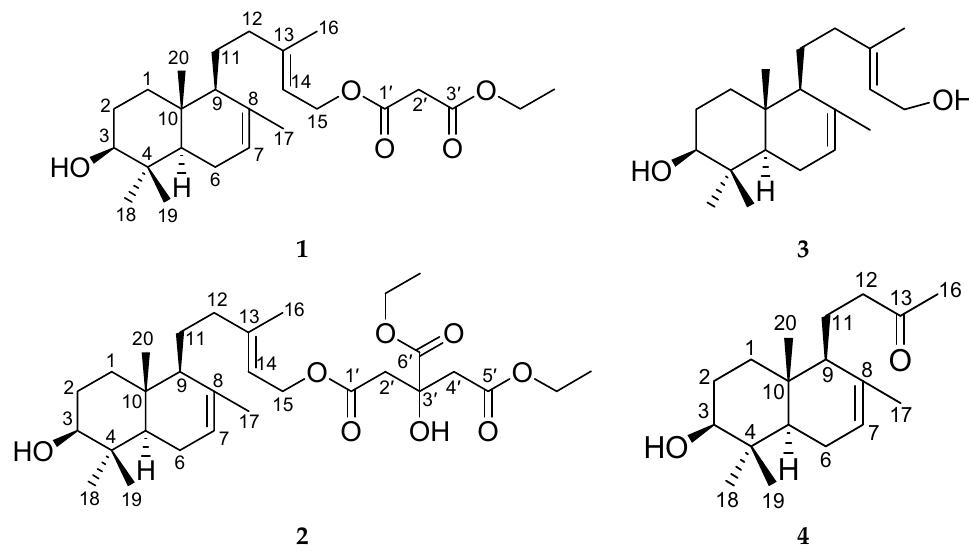
Figure 1. The chemical structures of compounds 1 – 4 from S. emodi .